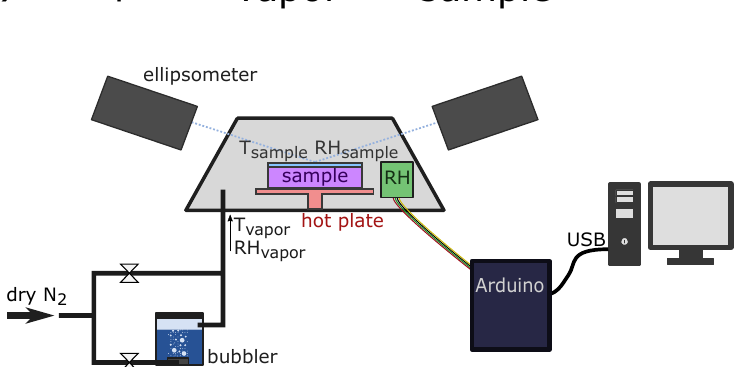
Figure 2. ( a ) Experimental setup of the custom-built interferometer placed inside the environmental chamber and operated by an Arduino from the outside. The blue laser illuminates the sample, and the reflected beam is measured by a photoresistor. ( b ) Setup with thermal gradients, where the sample is placed on a hot plate. The relative humidity is introduced via a bubbler system adjustable via two needle valves and tracked inside the chamber by a humidity sensor.